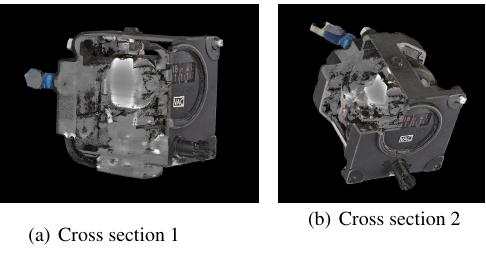
Figure 9. Cross sections of the integrated model